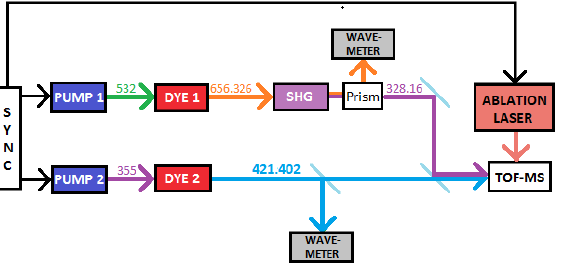
Figure 2. Experimental set-up for the laser photoionization study of Ag. PUMP 1 and PUMP 2 repre- sent the pump Nd:YAG lasers, while DYE 1 and DYE 2 represent the dye lasers, respectively. SHG is the second harmonic generation crystal and TOF-MS represents the time-of-flight mass